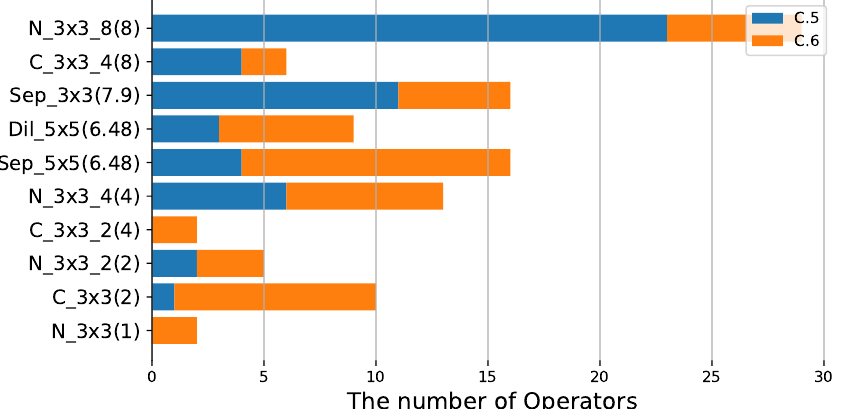
Figure 8. The distribution of operators in SOP1 when compressing resnet56 on Cifar10. C.5 and C.6 correspond to λ of 1.5 − 3 and 0, respectively. N _3 × 3_8 appears the most times in this experiment, indicating that N _3 × 3_8 has a better effectiveness. As λ increases, the algorithm tends to select the more lightweight operators, with blue histograms located in the upper part of the